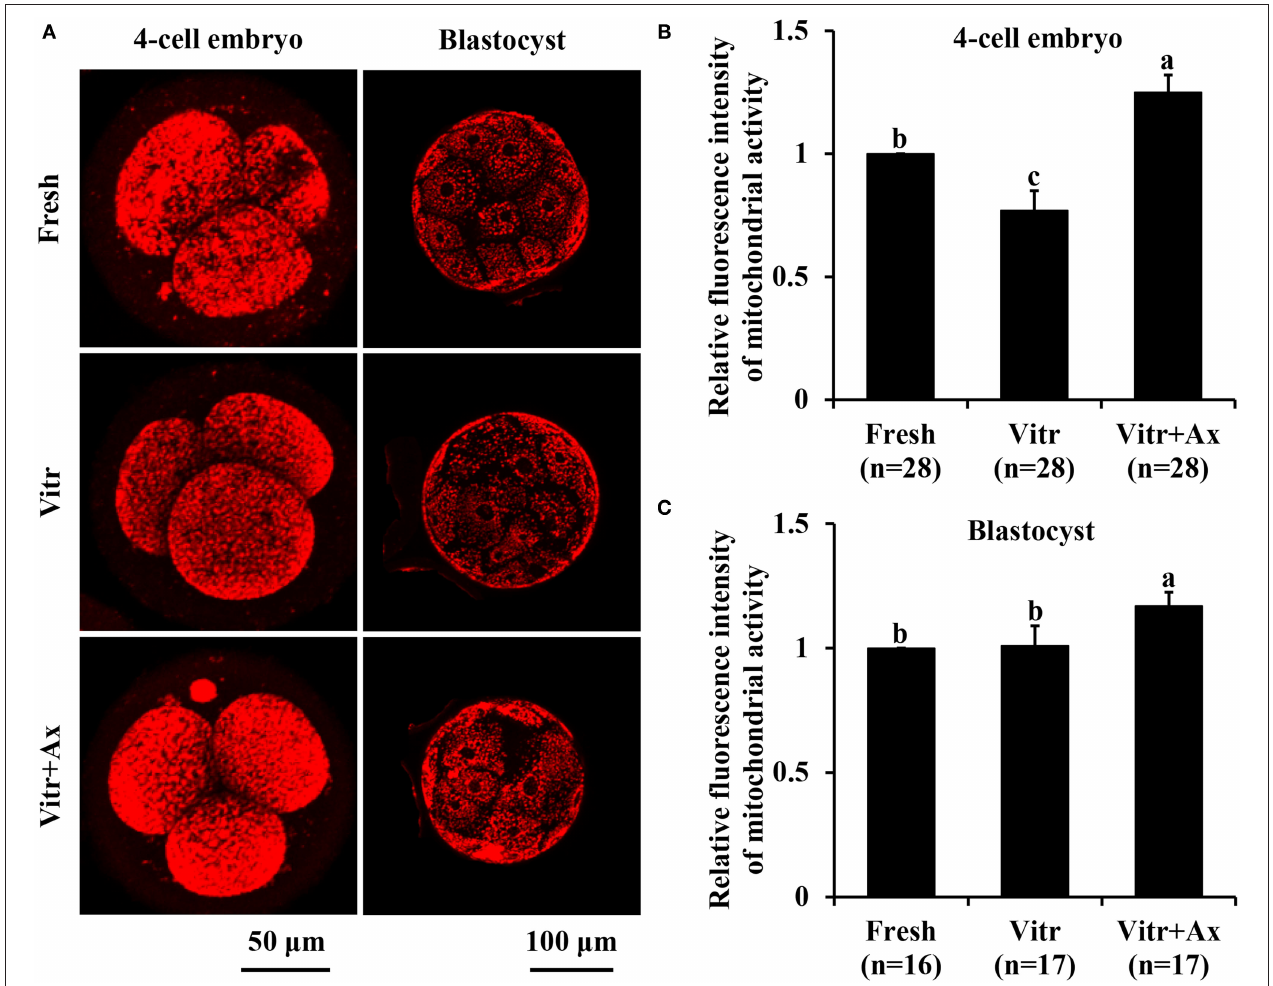
FIGURE 4 | Effects of astaxanthin (Ax) supplementation on intracellular mitochondrial activity in resultant 4-cell embryos and blastocysts. (A) Representative images of mitochondrial signals stained with MitoTracker TM Red CMXRos. (B,C) Graphical representation of mitochondrial activity by quantifying the relative fluorescence intensity. Four replications were performed. Data are the mean ± SEM values. Different superscripts above columns indicate significant differences ( P < 0.05). The three experimental groups: fresh zygotes (Fresh group), vitrified zygotes (Vitr group), and vitrified zygotes cultured with Ax (Vitr + Ax